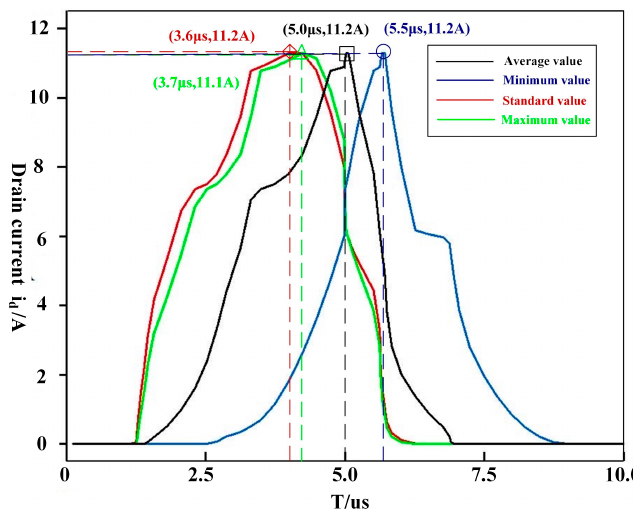
Figure 7. Simulation curves of i d and the maximum value, standard value, average value, and minimum value of L g .